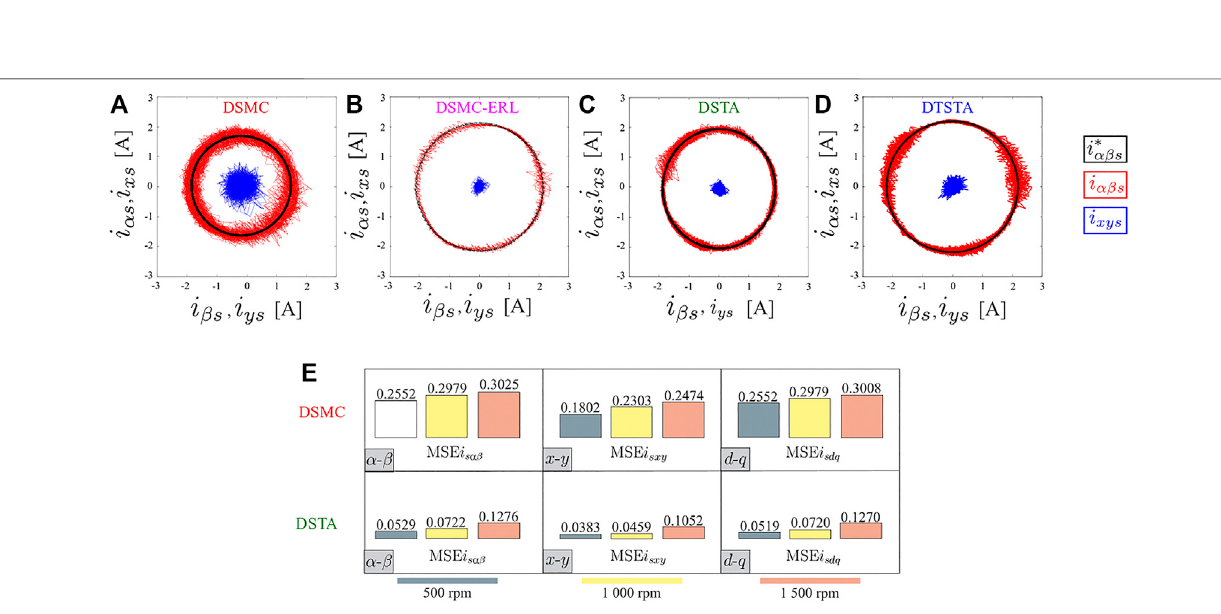
Frontiers in Energy Research |